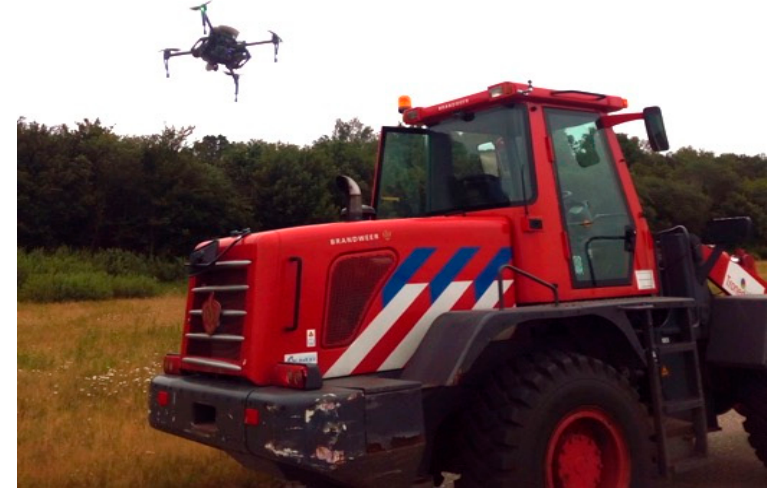
Figure 1. The DJI Matrice 100 hovers above a 2005 Foton tractor at the Twente Safety Campus in Enschede, The Netherlands.